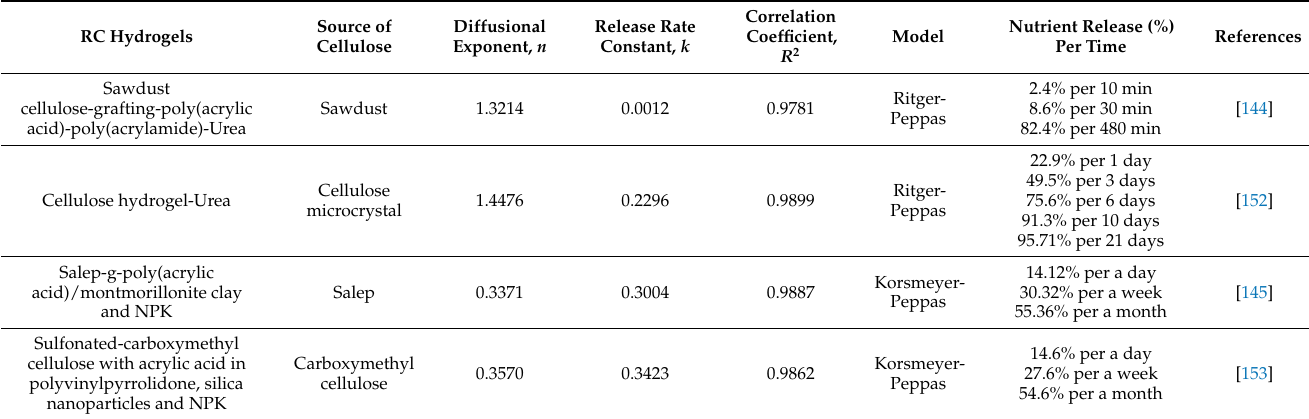
Table 6. Kinetic parameters of different types of RC hydrogels in soil.